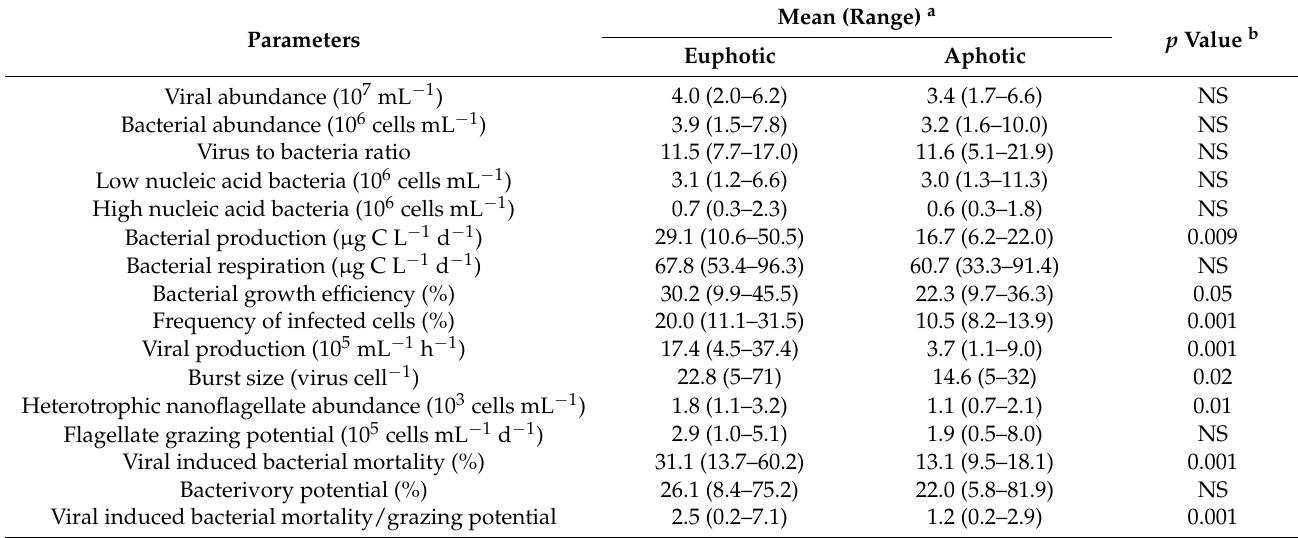
Table 3. Microbial characteristics of Lake Goule at the studied depths.